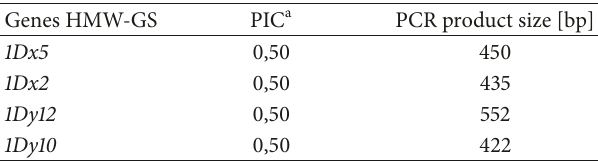
Table 4: Characteristics of STS markers